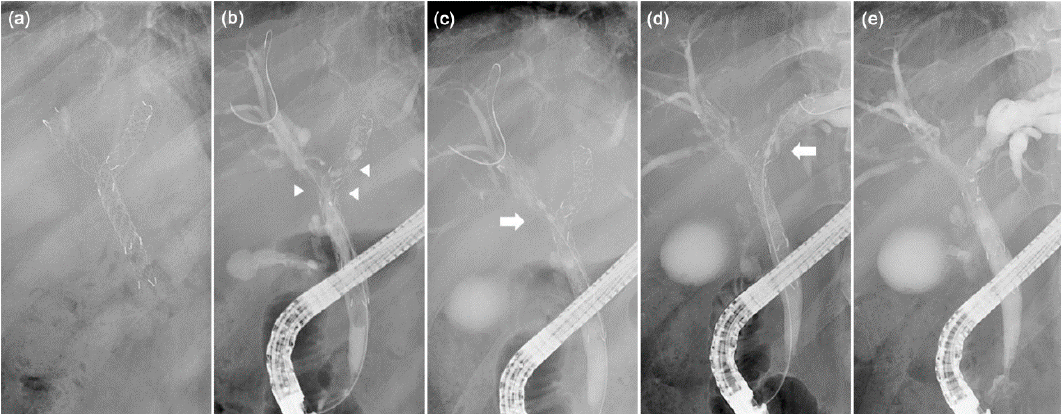
Figure 2. Application of endoscopic intraductal radiofrequency ablation (RFA) in a 64-year-old patient with hilar cholan- giocarcinoma. ( a ) Fluoroscopic view showing previous bilateral metal stents placed using the stent-in-stent method. ( b ) Cholangiogram showing partial occlusion of the metallic stent in the hilum and total occlusion in the left hepatic duct (arrowhead) due to tumor ingrowth. ( c , d ) RFA catheter (arrow) inserted in the hepatic duct and ablation performed within the metal stent. ( e ) Cholangiogram showing restoration of luminal strictures after RFA.